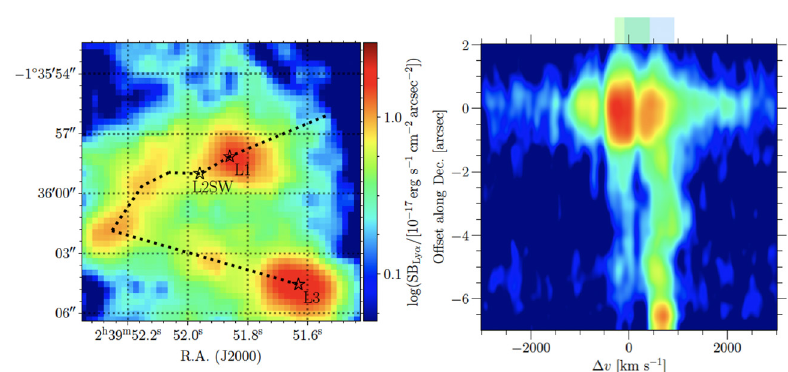
Figure 2: Position-velocity map of the Ly ↵ nebula on the right taken along the track shown in the left panel (black dots). The blue and green boxes at the top show the full velocity coverage of the CH + absorption lines in front of L2SW and L1, respectively.